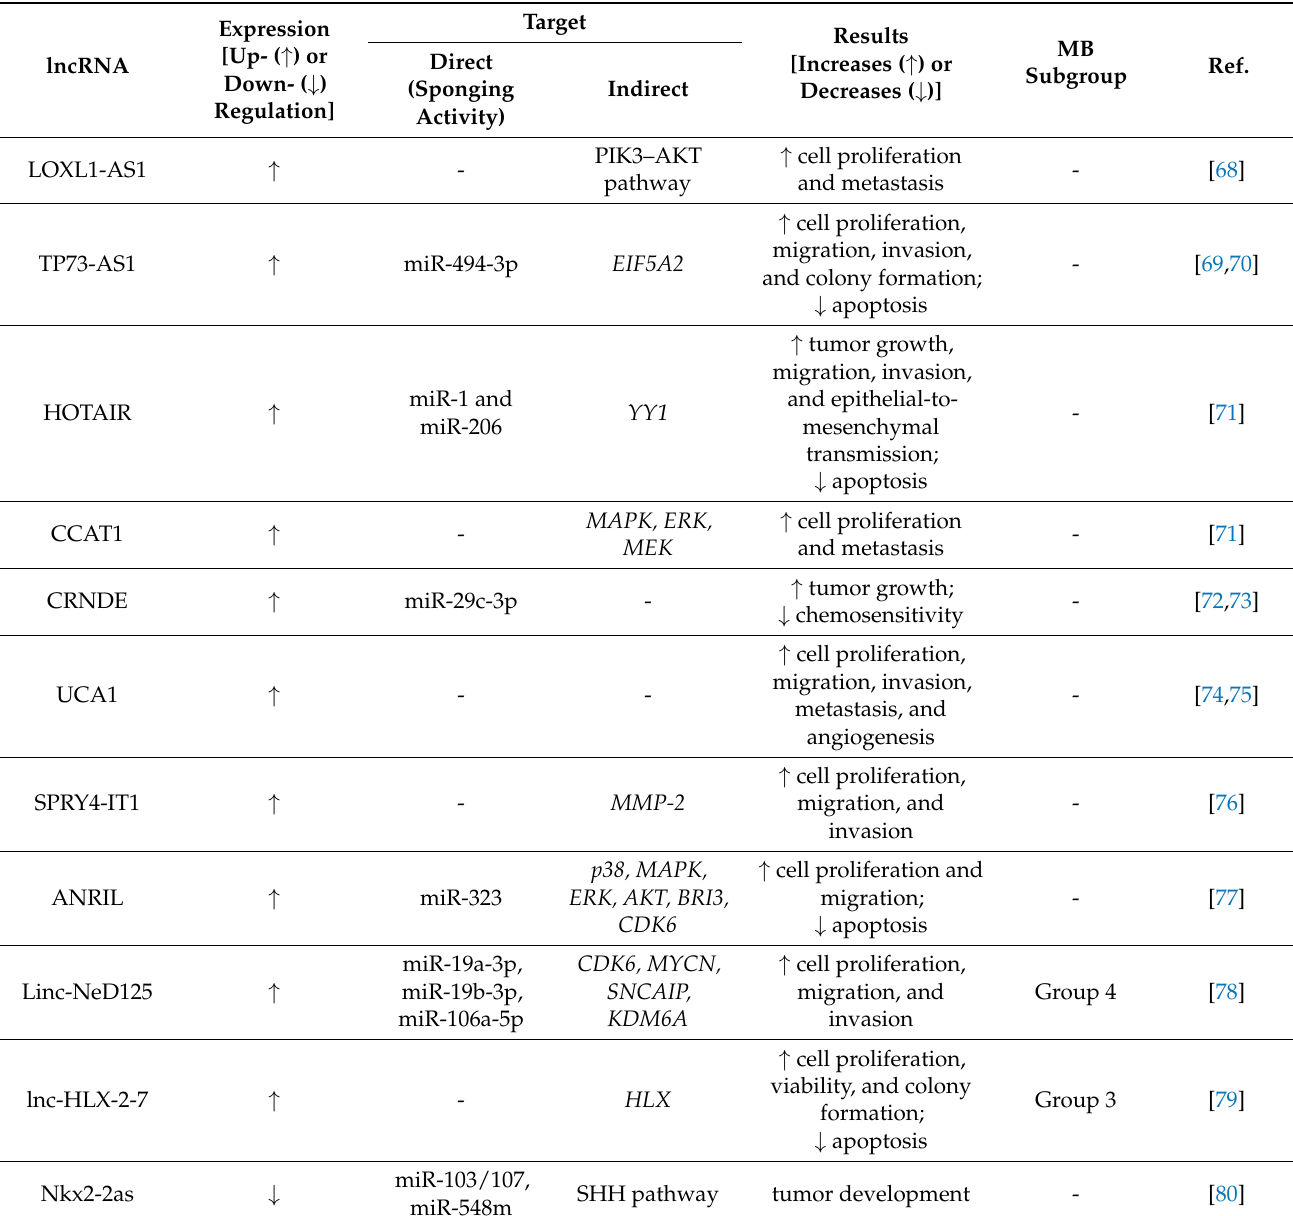
Table 3. Dysregulated lncRNAs in MB and their functional